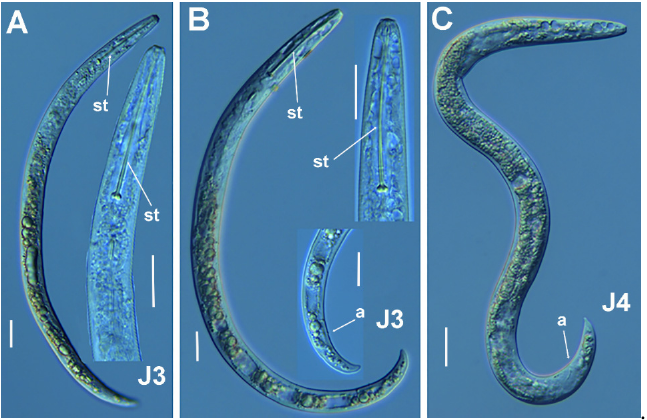
Figure 2. Micro-photomicrographs of Paratylenchus paraaonli sp. nov. female. ( A ) Whole female with stylet and vulva arrowed; ( B ) pharyngeal region; ( C , D ) detail of female stylet region; ( E ) detail of lateral fields; ( F – H ) female posterior region with vulva and anus (arrowed) and detail of vulva showing advulval flap (arrowed); ( I ) female tail; ( J ) detail of spermatheca (arrowed). Scale bars ( A = 50 μ m; B – J = 20 μ m). (Abbreviations: a = anus; avf = advulval flap; ep = excretory pore; lf = lateral field; st = stylet; spm = spermatheca; st = stylet; V = vulva).